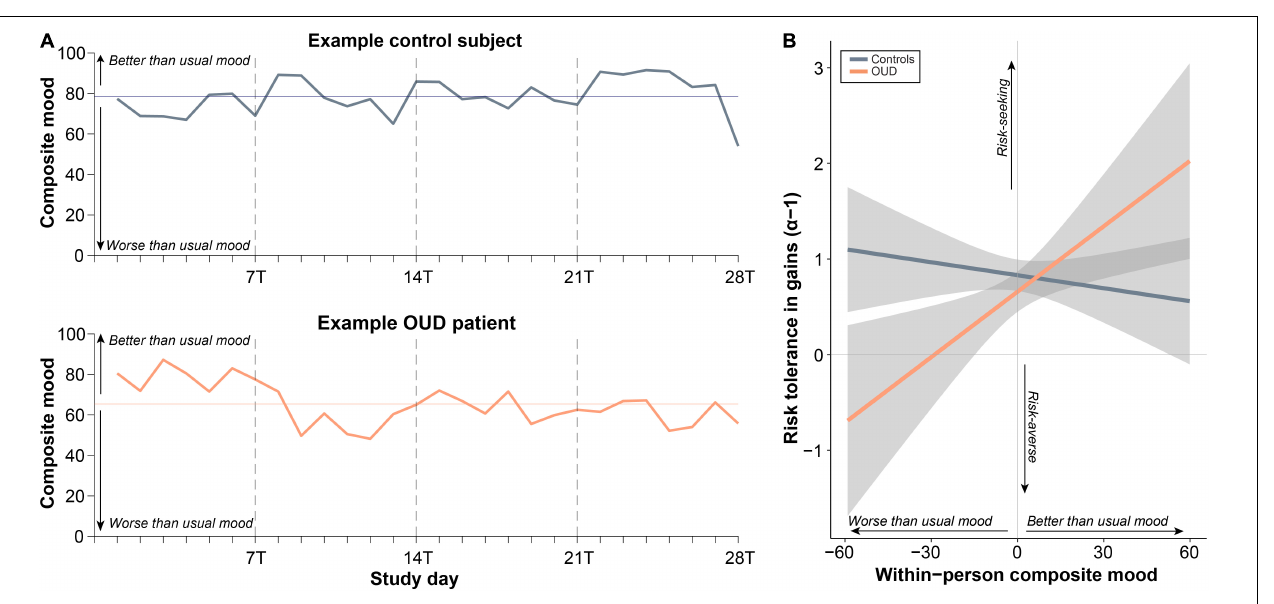
FIGURE 5 | Within-person changes in psychological mood state relate to changes to risk tolerance in gains. (A) Ratings of composite mood showed substantial within-person variability across the study days as determined by the intraclass correlation coefficient (ICC; variance due to between-person relative to within-person variability). (B) Better than usual mood was associated with more risk tolerance, especially in patients with opioid use disorder (OUD) (see section